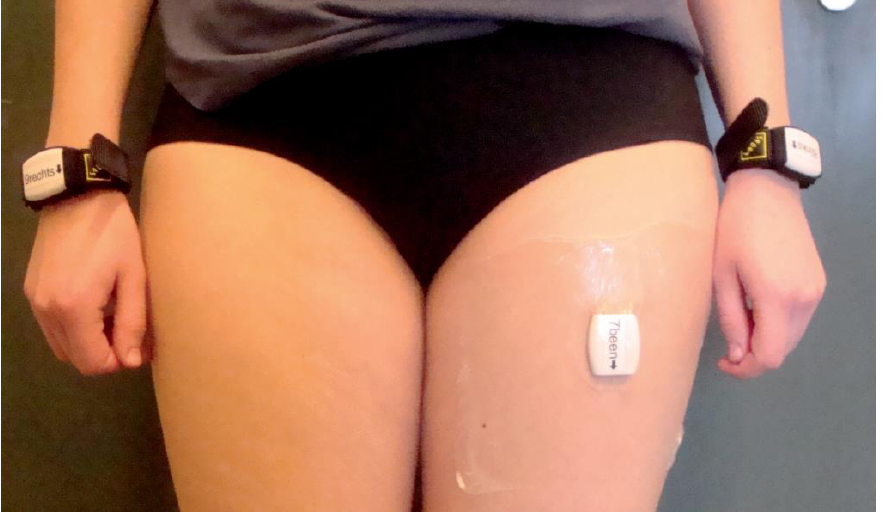
Figure 1. Participants wore three accelerometers: One accelerometer on each wrist and one accelerometer on the upper leg of the nonparetic side of the body.